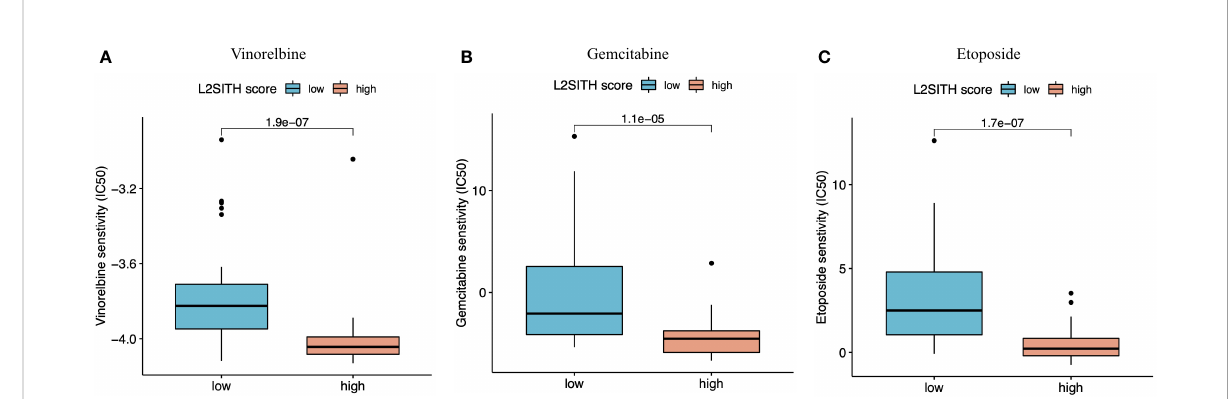
FIGURE 9 Potential bene fi cial drugs to patients with LUAD grouped by L2SITH score. (A) Vinorelbine, (B) gemcitabine, and (C) etoposide were inferred to bene fi t the low-scored LUAD